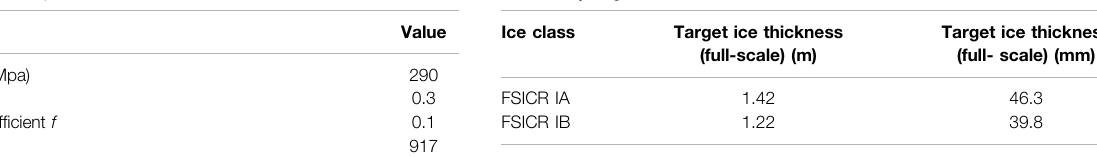
TABLE 2 | Characteristic parameters of brash ice. TABLE 3 | Target brash ice